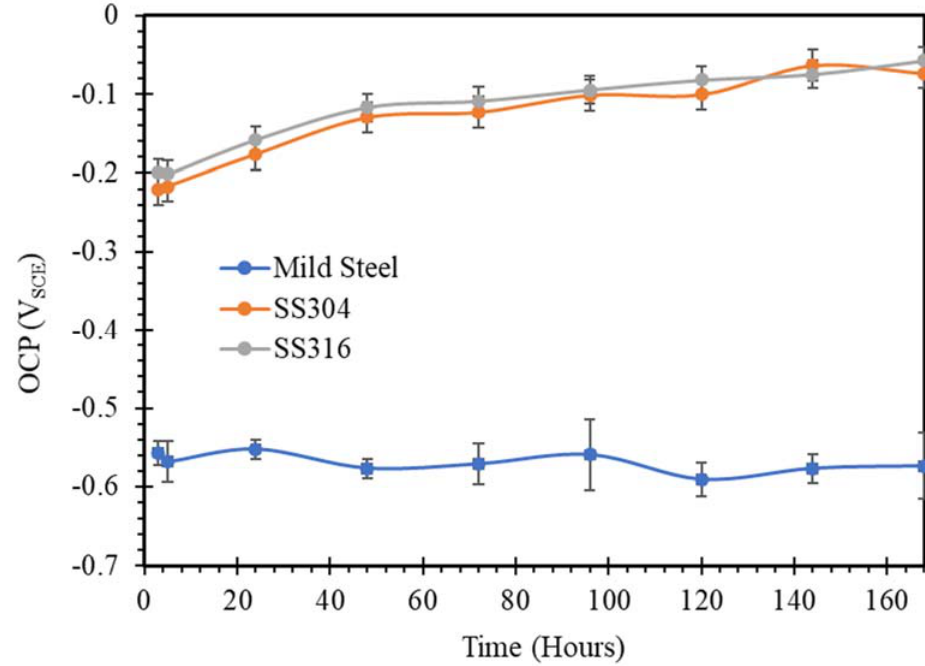
Figure 5. OCP vs. time plots of mild steel, SS304 and SS316 in SWSSHPC solution.